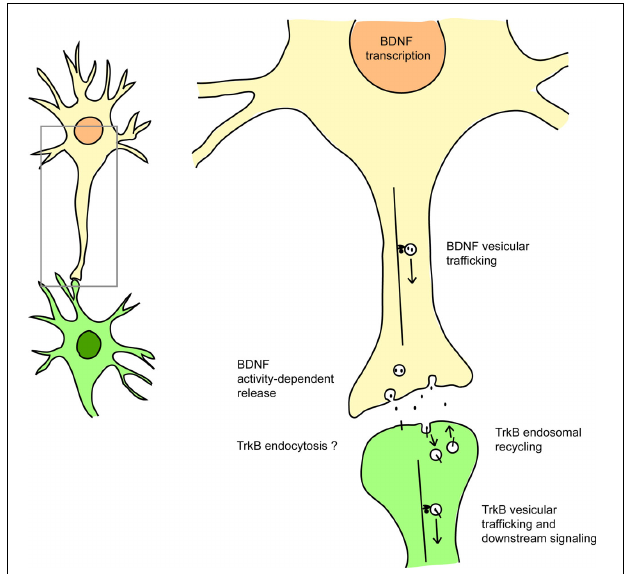
FIGURE 1 | HTT affects BDNF/TrkB signaling at many levels. HTT regulates BDNF transcription (via the sequestration of REST/NRSF), BDNF vesicular trafficking (via interaction with the molecular motors dynein and kinesin), the activity-dependent release of BDNF, and also TrkB retrograde vesicular trafficking (via HAP1 interaction). HTT also affects Rab11-dependent endosomal recycling. HTT could also modulate TrkB endocytosis via its interaction with HAP40 and early endosomal trafficking via its interaction with Rab5. See references in the